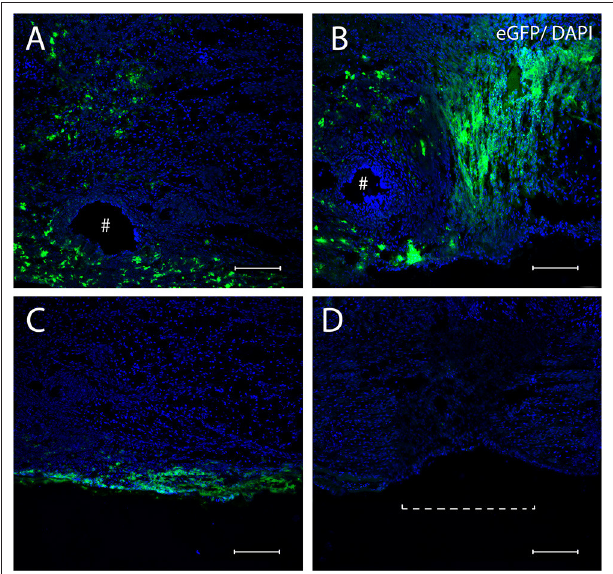
FIGURE 5 | Electroneuromyography measurements. X-axis, testing time: before injury; 30 day and 60 day after injury. Y-axis, CMAP threshold (in volts); CMAP amplitude (in millivolts); CMAP onset latency (in milliseconds) and Duration of CMAP (in milliseconds). Differences were statistically significant between the groups (*), between AG + FG + ADSCs and AG-groups; (**), between experimental and intact groups (* , **- P < 0.05, one-way ANOVA, Tukey’s test).